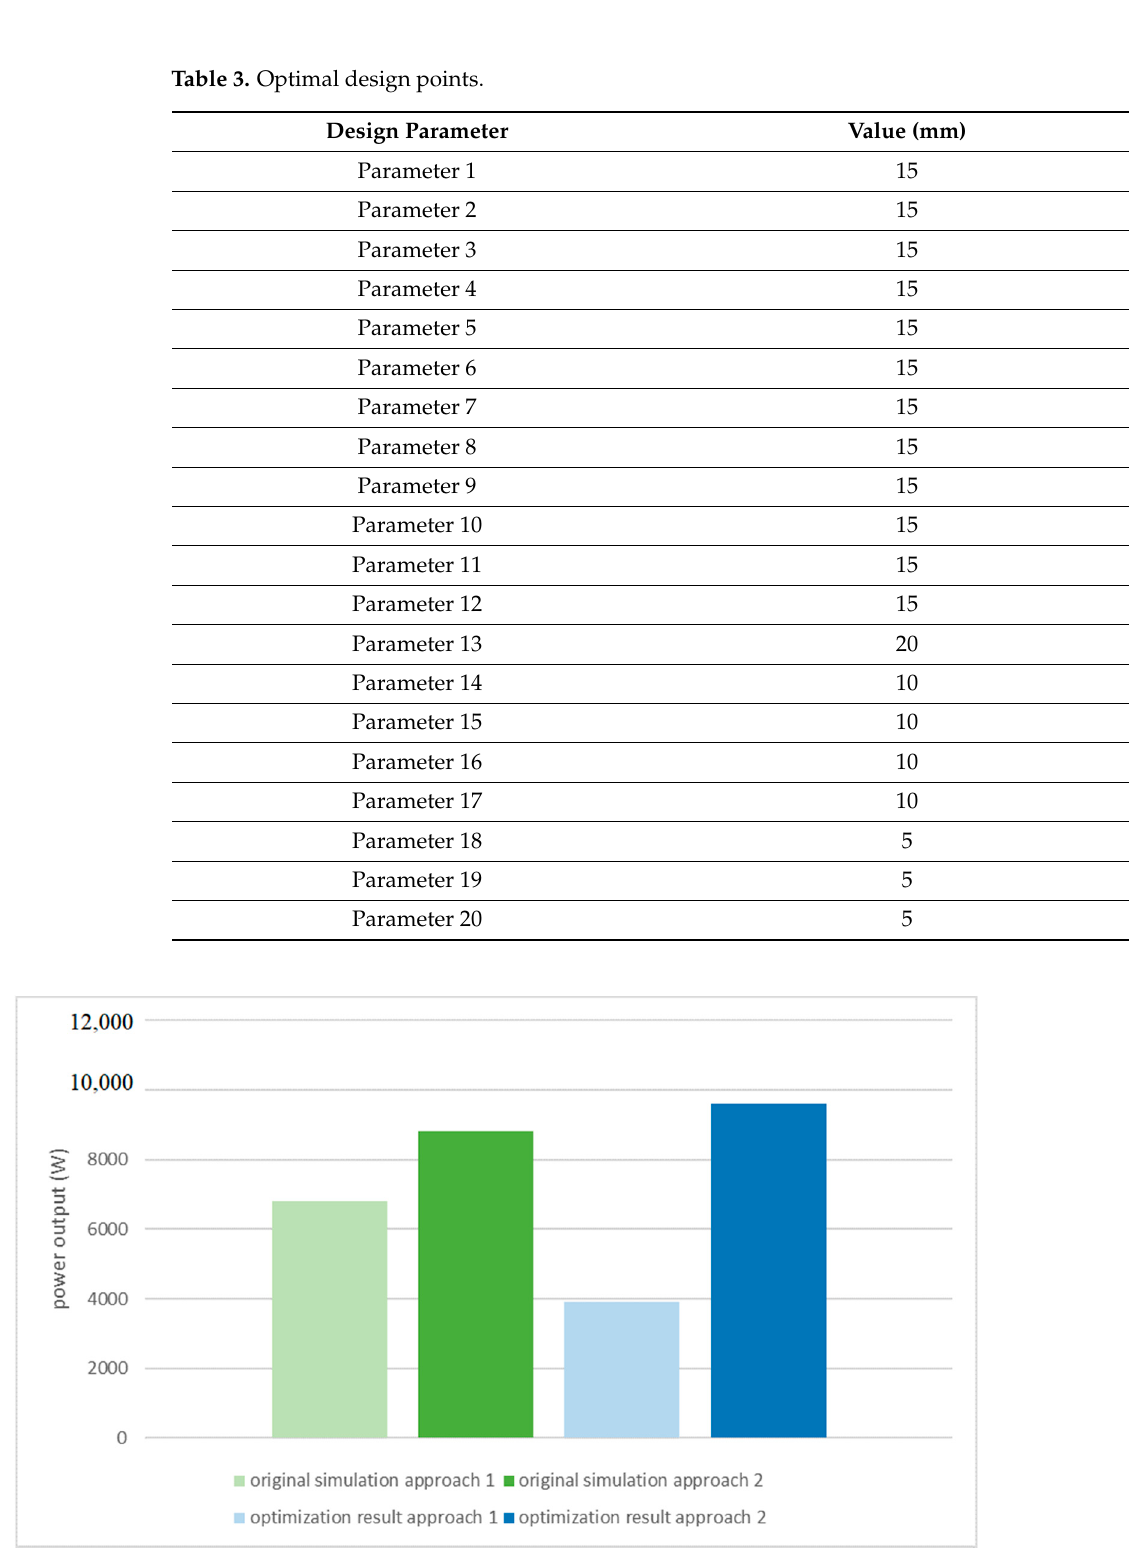
Table 3. Optimal design points.